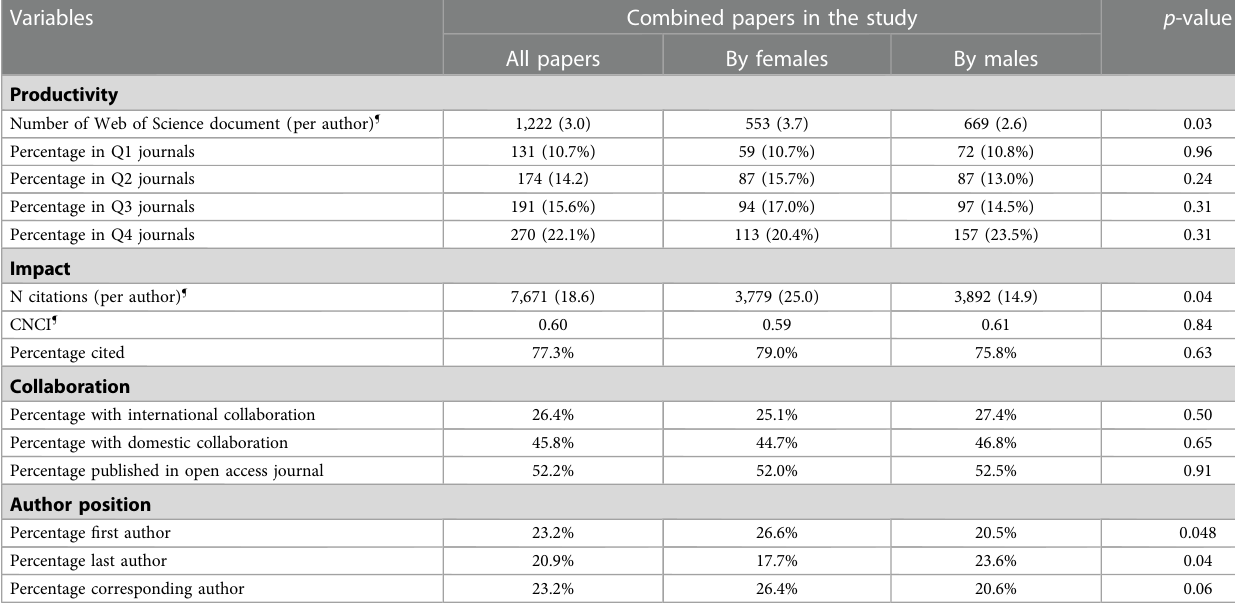
TABLE 2 Comparison between male and female authors af fi liated with Nigerian institutions regarding research productivity, impact, collaboration patterns, open access publishing and authorship patterns in dentistry and oral sciences.